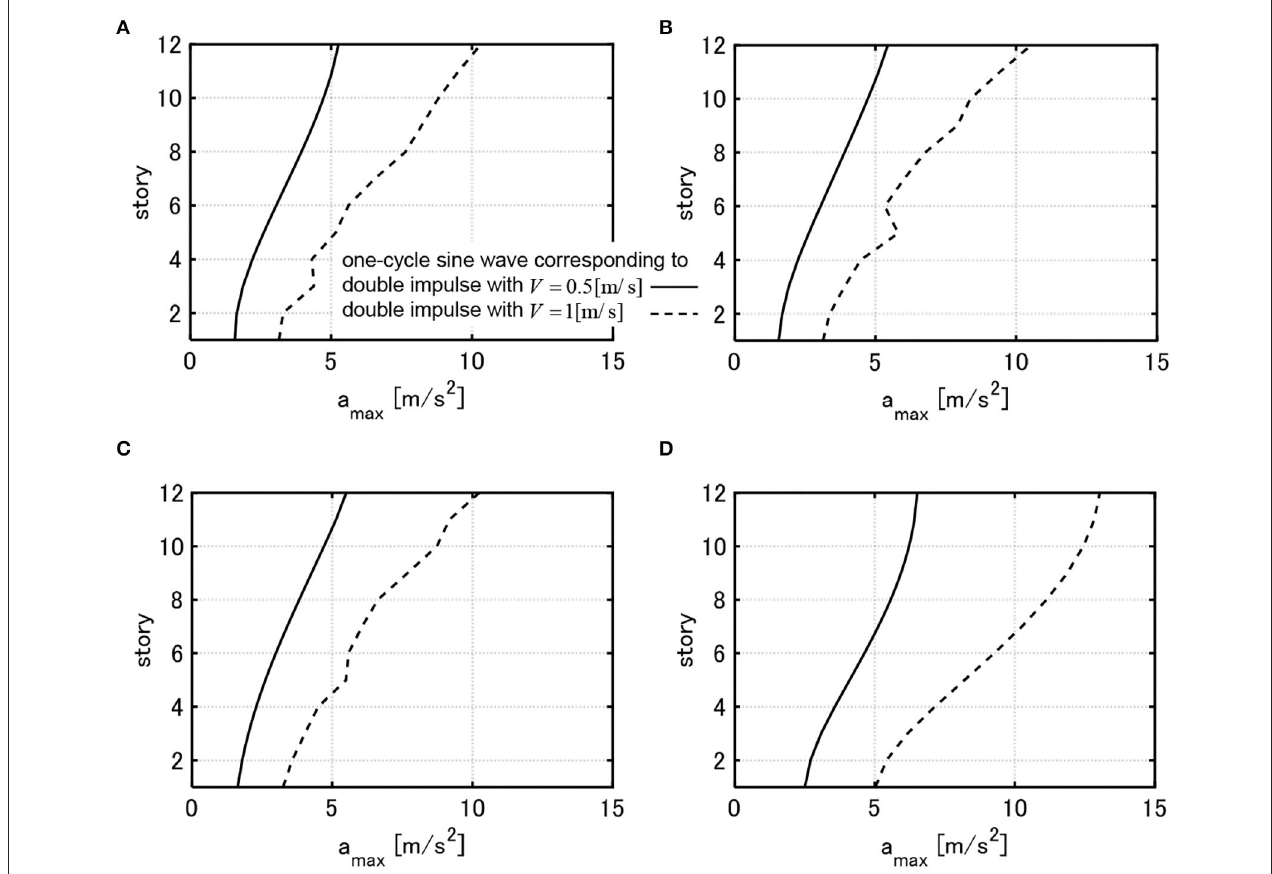
FIGURE 12 | Maximum floor acceleration of 3 models with W cF = 20 × 10 7 [ Ns / m ] and these initial design model under one-cycle sine wave corresponding to critical double impulse with V = 0.5, 1.0[ m / s ]. (A) Model designed under critical double impulse with V = 0.25[ m / s ]. (B) Model designed under critical double impulse with V = 1.0[ m / s ]. (C) Model designed under critical double impulse with V = 1.5[ m / s ]. (D) Initial design.